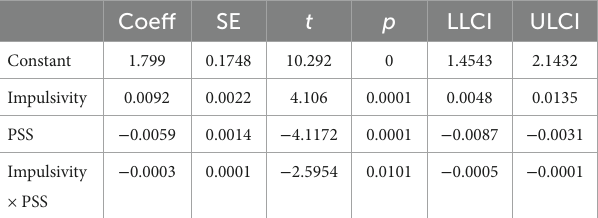
TABLE 6 The result of moderating effects analysis of impulsivity, PSS, and SCL-90 ( N = 228). Coeff